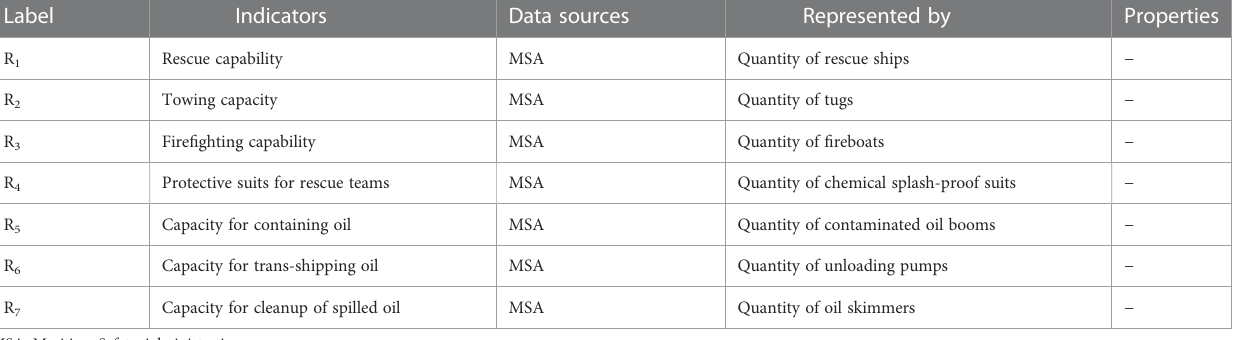
TABLE 3 Response indicators (after Wang et al., 2018a).